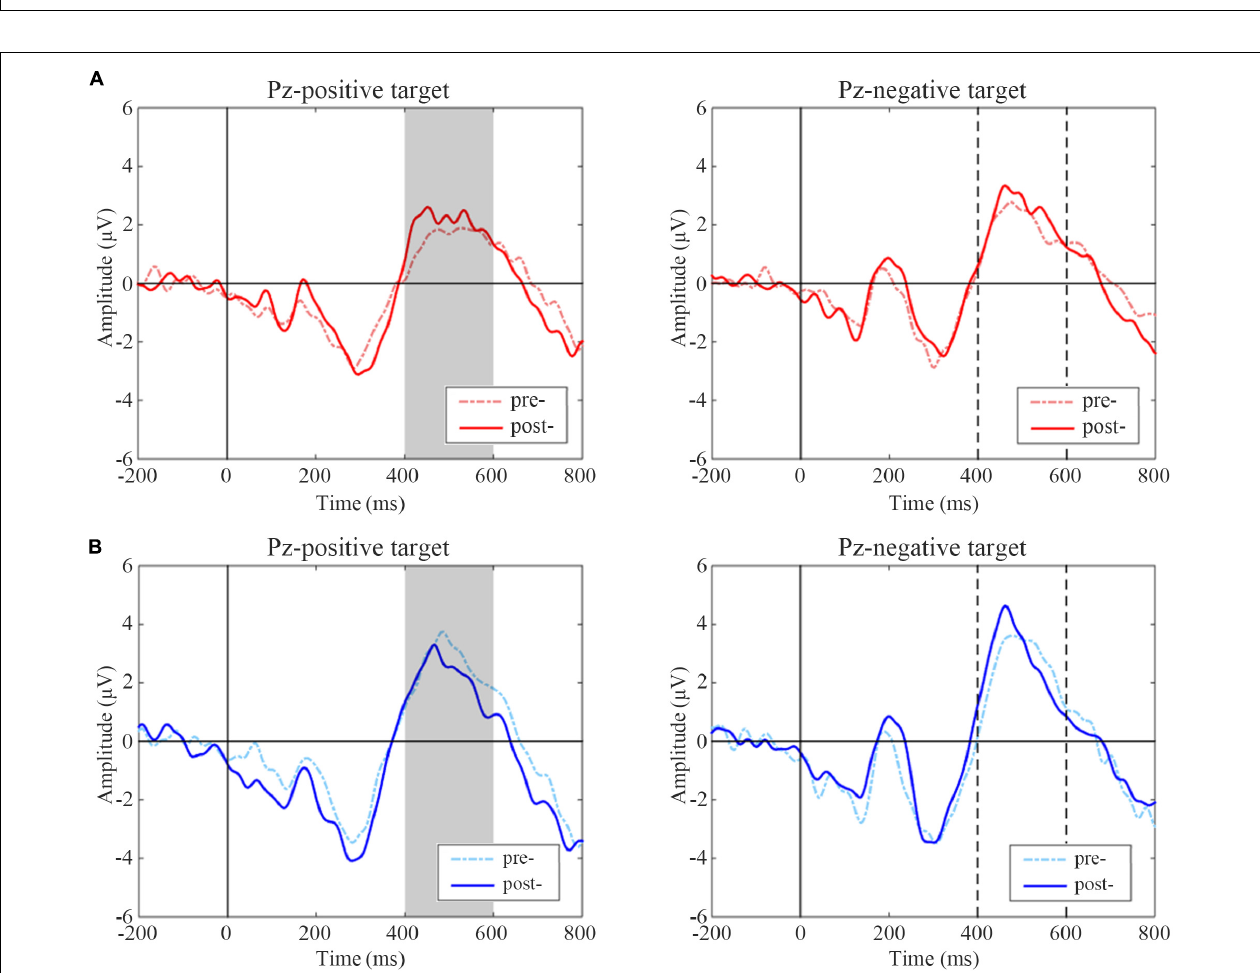
FIGURE 5 | Event-related potentials (ERP) difference waves of pre- and post-treatment tests for positive and negative targets in two groups. (A) Active group, (B) Sham group. The gray-filled area indicates the period with a significant difference. The gray dotted lines indicate the time points at 400 and 600 ms.